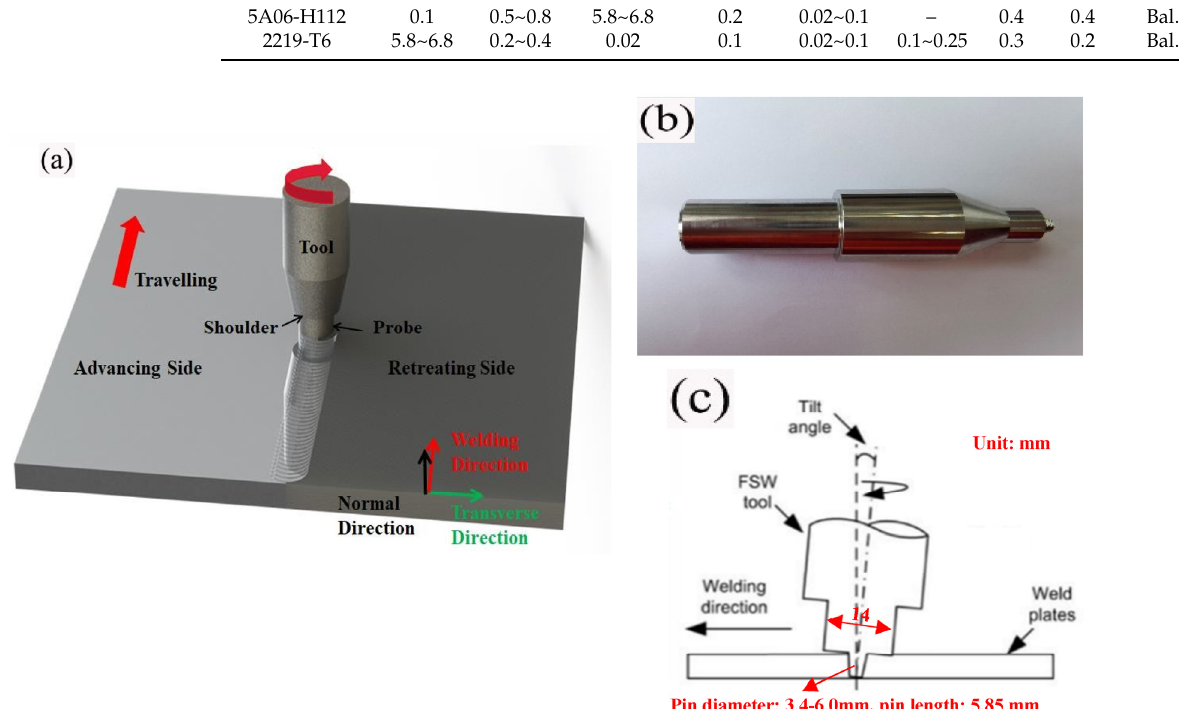
Figure 1. Schematic illustration of FSW process ( a – c ) tool pin profile.